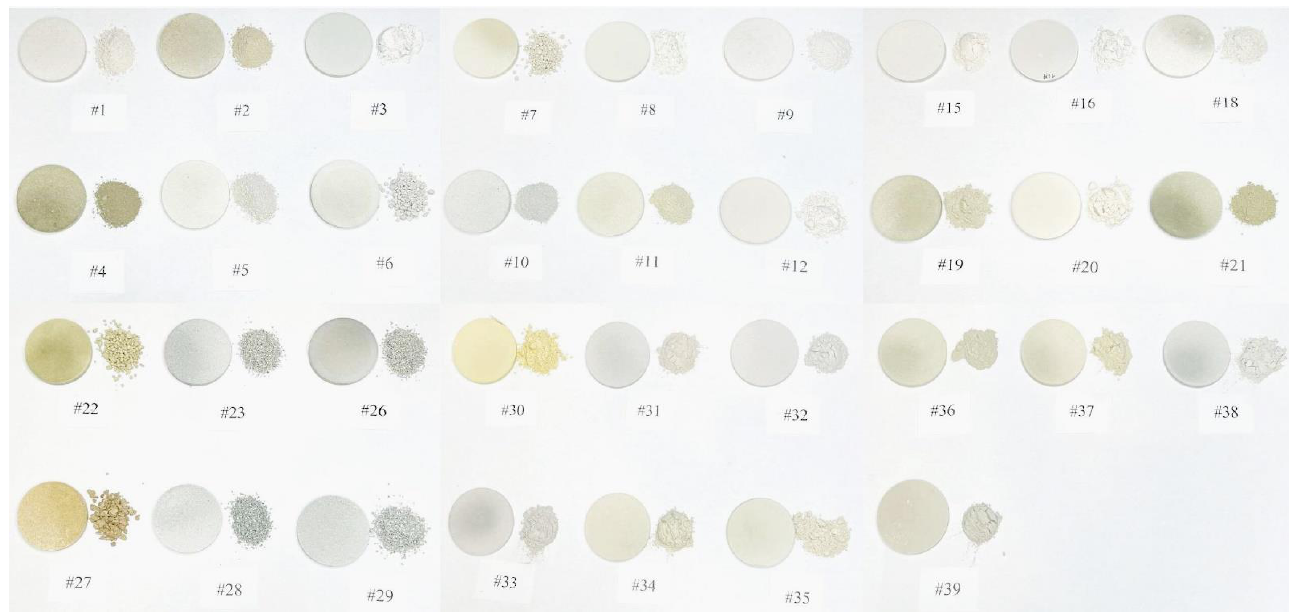
Figure 1. Collage of all bentonites included in this study. The left part of each product shows the pressed pellet for X-ray fluorescence analysis and the right side shows the bentonite in its commercial form.